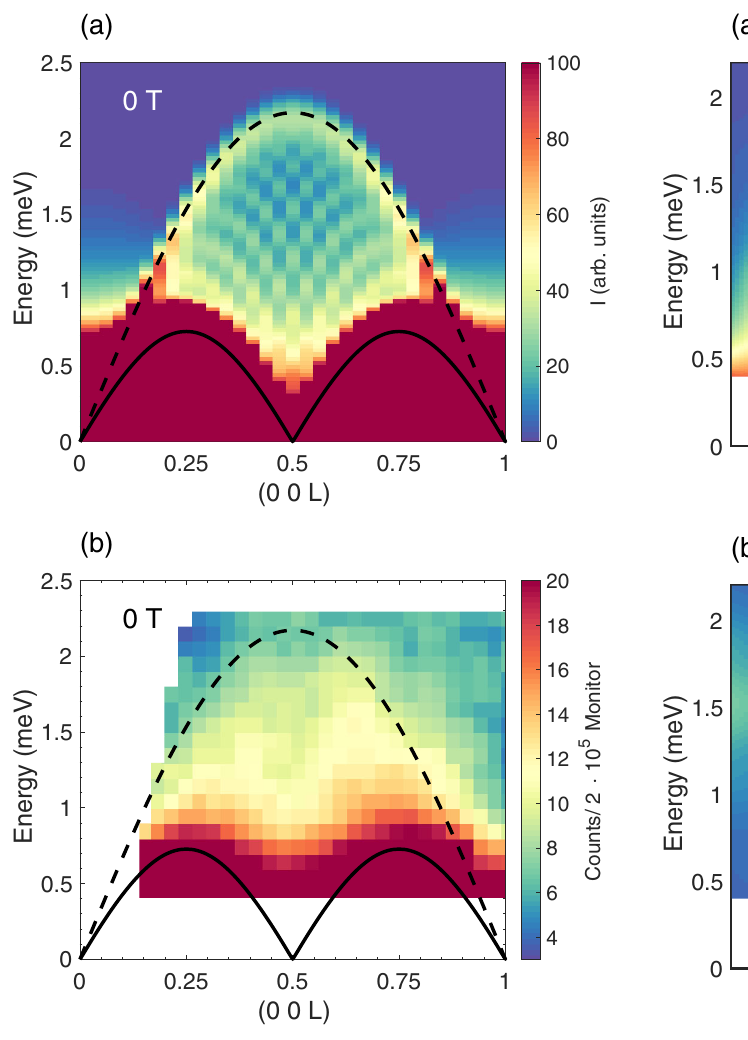
Fig. 3 The transverse and longitudinal components of the excitation spectrum. The calculated neutron scattering cross section in Fig. 4d at 22 K and 7 T separated in its a longitudinal and b transverse parts, proportional to ð g z Þ 2 S zz and 0 : 65 ð g x Þ 2 S xx þ 0 : 35 ð g y Þ 2 S yy , respectively (see Supplementary Note 4). The MBO signal is only present in the transverse part of the signal. The black arrows correspond to the prediction of the effective Bloch energy, _ ω (cid:5) , given by equation (7). B The colour scale is the same for the two